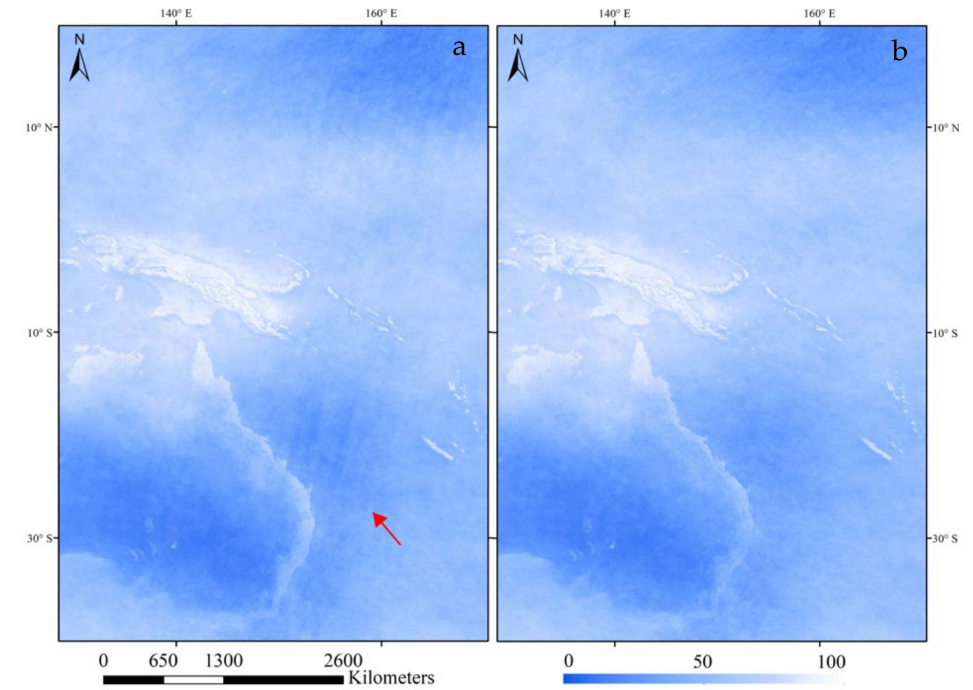
Figure 16. Comparison of stripe noise before ( a ) and after ( b ) removal on the east coast of Australia in GLHCC01. The red arrow points to the striped